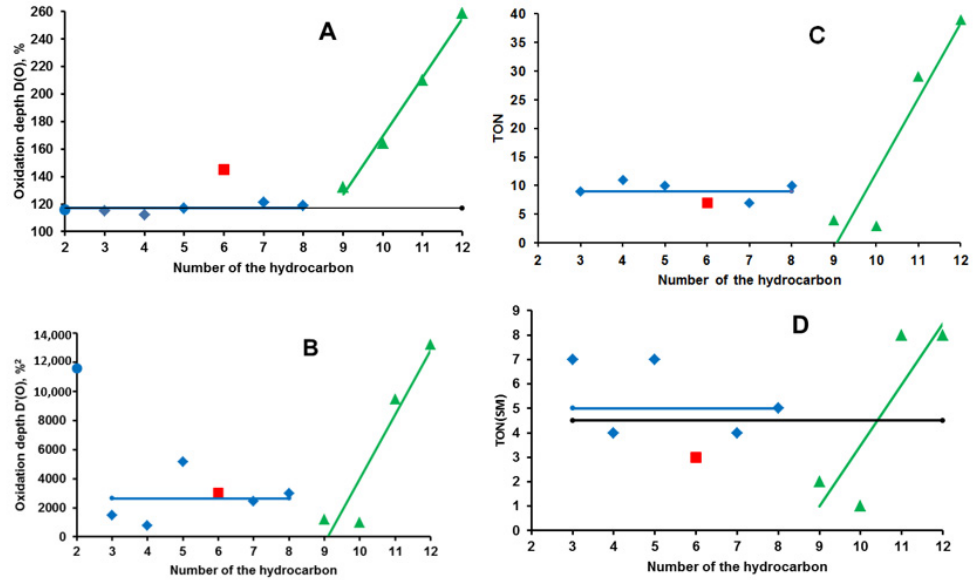
Figure 2. The depths D(O), D’(O), TON and TON(SM) (respectively A – D ) of oxidation of hydrocarbons No. 2 – 12 . The points with D(O) = 117 ± 5% are blue, with D(O) > 117 ± 5% are red and green, No. 6 —camphor is a ketone, highlighted in red.